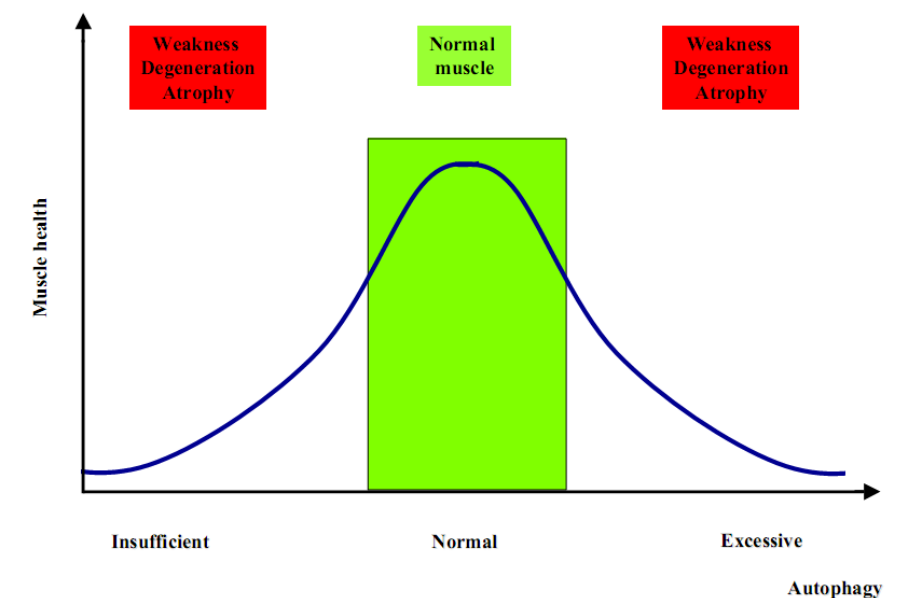
Figure 1. Insufficient or excessive autophagy is detrimental for muscle